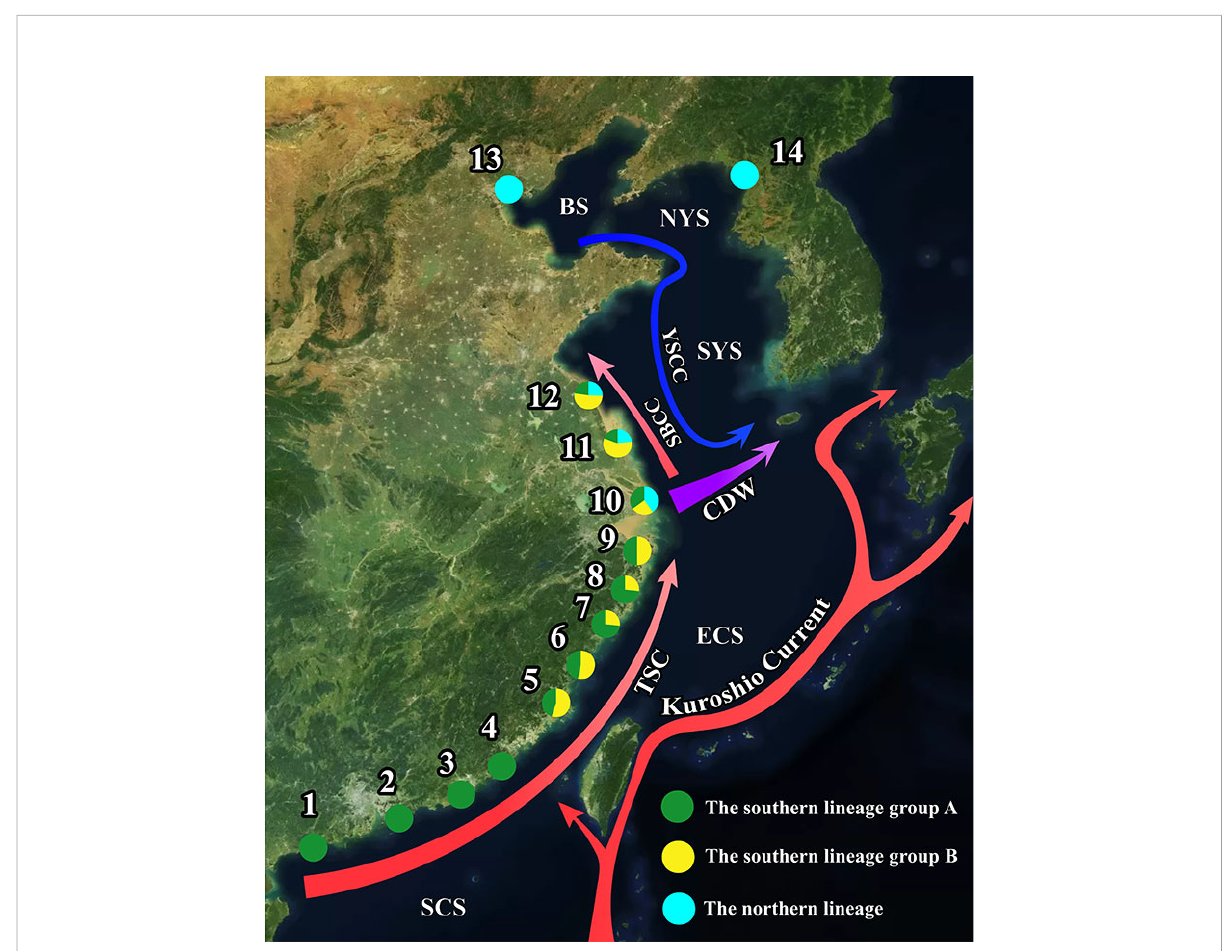
FIGURE 1 A map depicting sampling sites, distribution of lineages and intra-lineage haplotype groups and summer hydrographical conditions (drawn based on Yuan et al., 2017; Liu et al., 2021). Sampling sites are numerically coded from south to north: 1. Yangjiang, 2. Shenzhen, 3. Shanwei, 4. Raoping, 5. Fuding, 6. Rui ’ an, 7. Dongtou, 8. Taizhou, 9. Ningbo, 10. Shanghai, 11. Rudong, 12. Lianyungang, 13. Tianjin, and 14. Dandong. Percentages of lineages and haplotype groups in each sample site are shown in pie charts. Abbreviations for ocean currents, freshwater discharge and seas: TSC, the Taiwan Strait Current; CDW, the Changjiang Diluted Water; SBCC, the Subei Coastal Current; YSCC, the Yellow Coastal Current; YSWC, the Yellow Sea Warm Current, SCS, the South China Sea; ECS, the East China Sea; SYS, the South Yellow Sea; NYS, the Northern Yellow Sea; BS, the Bohai